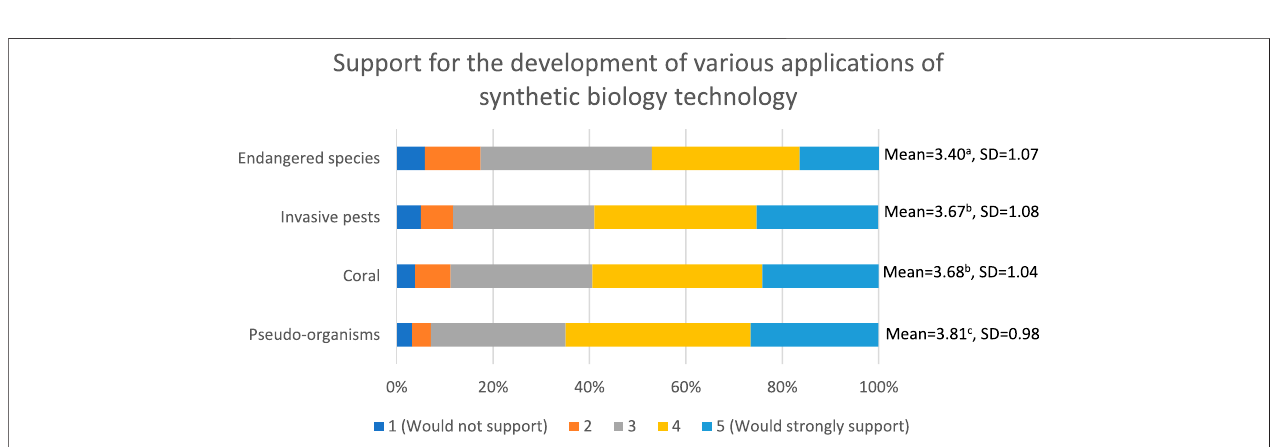
FIGURE 4 | Support for the development of various applications of synthetic biology technology. Notes: Different superscripts (a, b, c, and d) denote statistically signi fi cant differences between the means.